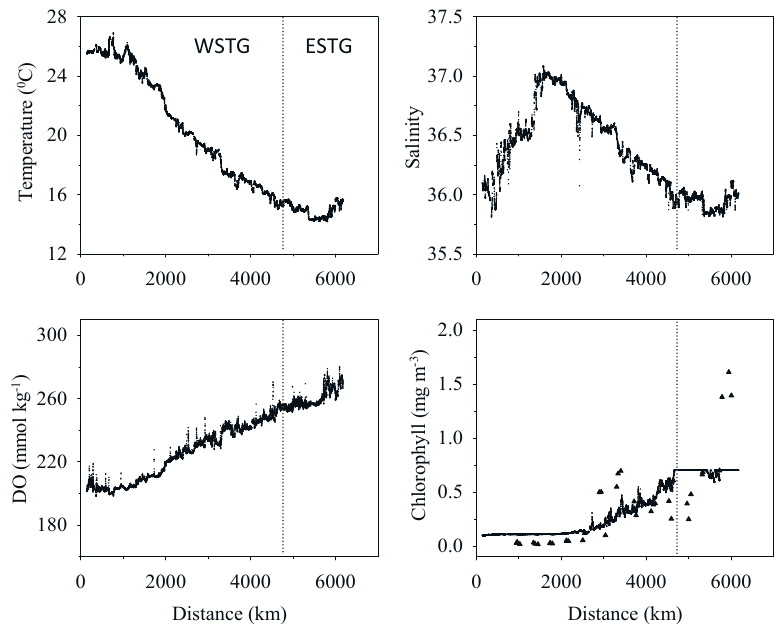
Figure 2. Changes in sea surface temperature, salinity, dissolved oxygen (DO) and chlorophyll during the campaign. Triangles show the chlorophyll concentration in discrete samples. In each graph the dotted line demarcates the western and eastern parts of the subtropical gyre (WSTG and ESTG).